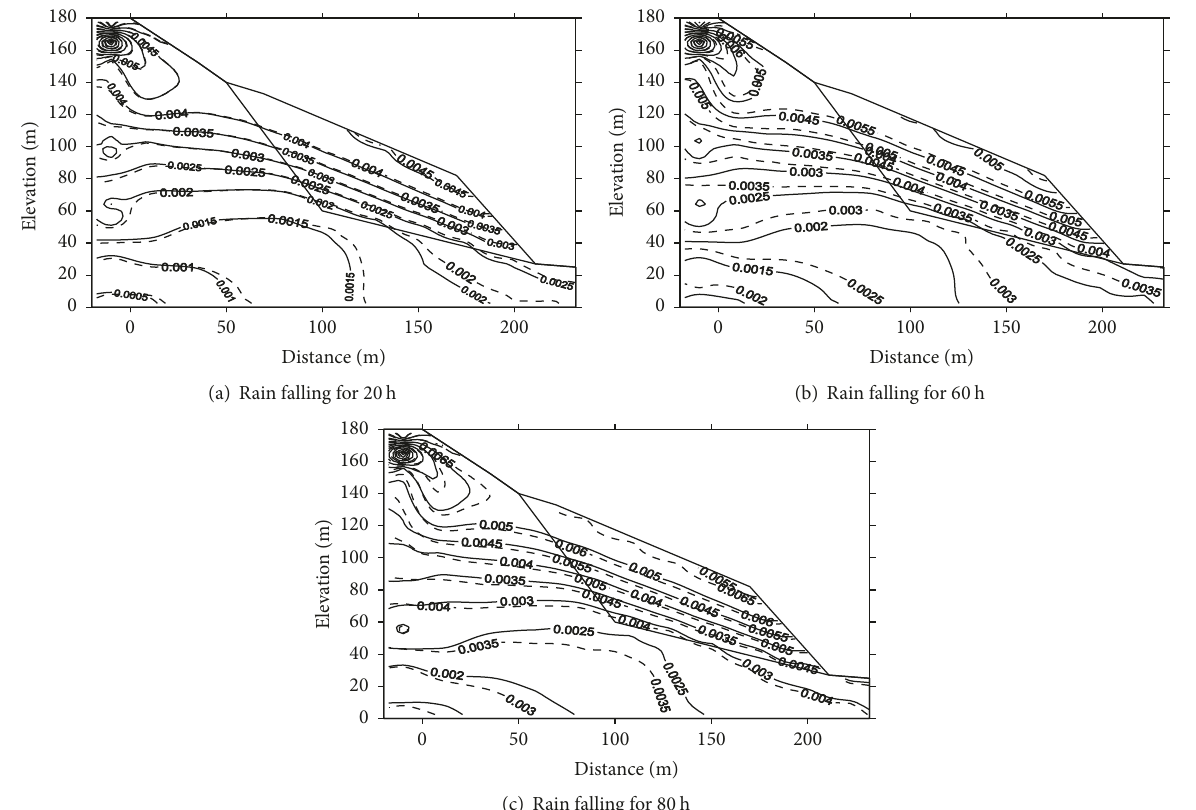
Figure 14: Total displacement contours for coupling (dashed line) and uncoupling (solid line) (20